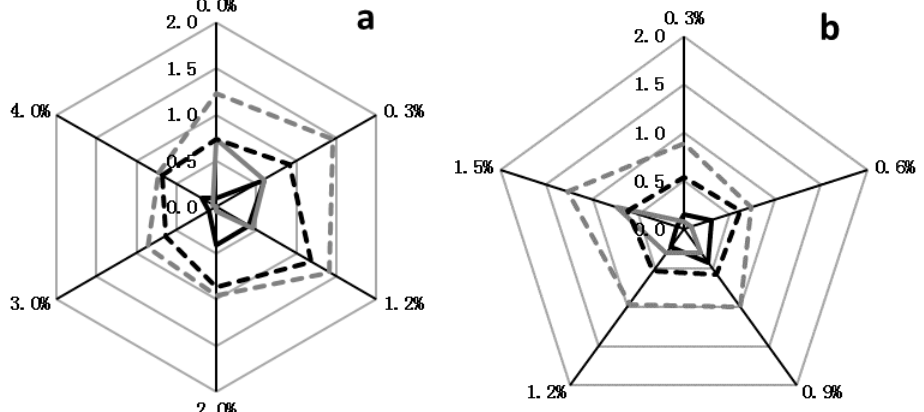
Figure 2. Aroma profiles of bread crumbs for the attributes cheesy (grey line), rose-like (black line), fatty (black dashed line) and buttery (grey dashed line) at ( a ) different NaCl concentrations (0.0%, 0.3%, 1.2%, 2.0%, 3.0% and 4% w/w) and ( b ) different yeast levels (0.3%, 0.6%, 0.9%, 1.2% and 1.5% w/w) on a scale from 0 (not detectable) over 1 (weak intensity) to 2 (medium intensity), as determined by sensory panel.